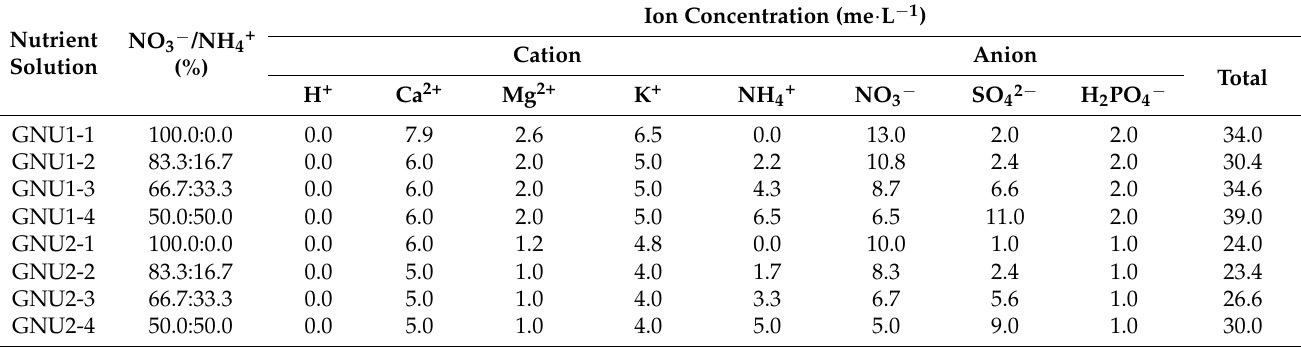
Table 4. Concentrations of macro-element cations and anions used in nutrient solutions in experiment 2.